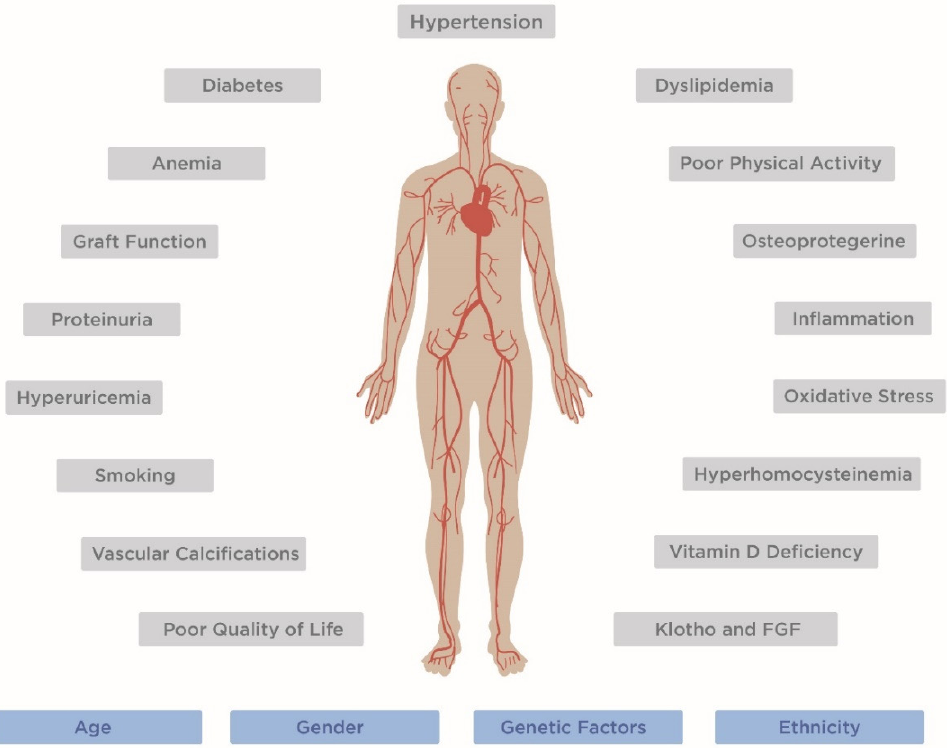
Figure 1. Factors involved in CVD development in kidney transplant recipients. Non-modifiable risk factors are marked in blue, modifiable risk factors are marked in grey. FGF, fibroblast growing factor.